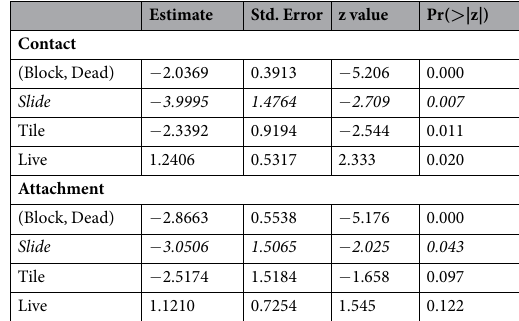
Table 3. Summaries of larvae contact (upper table) and attachment (lower table) bias-reduced logistic regression